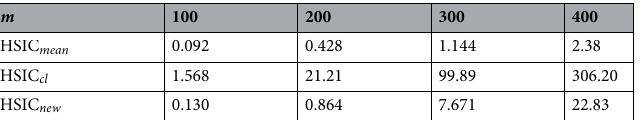
Table 4. Average runtimes in seconds from 10 simulations for each number of clusters m . All experiments were run by R on 2.2 GHz Intel Core i7.